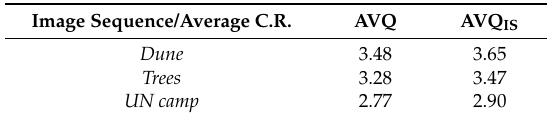
Table 7. Average PSNR (dictionary composed by 4096 entries)–Dataset 2.